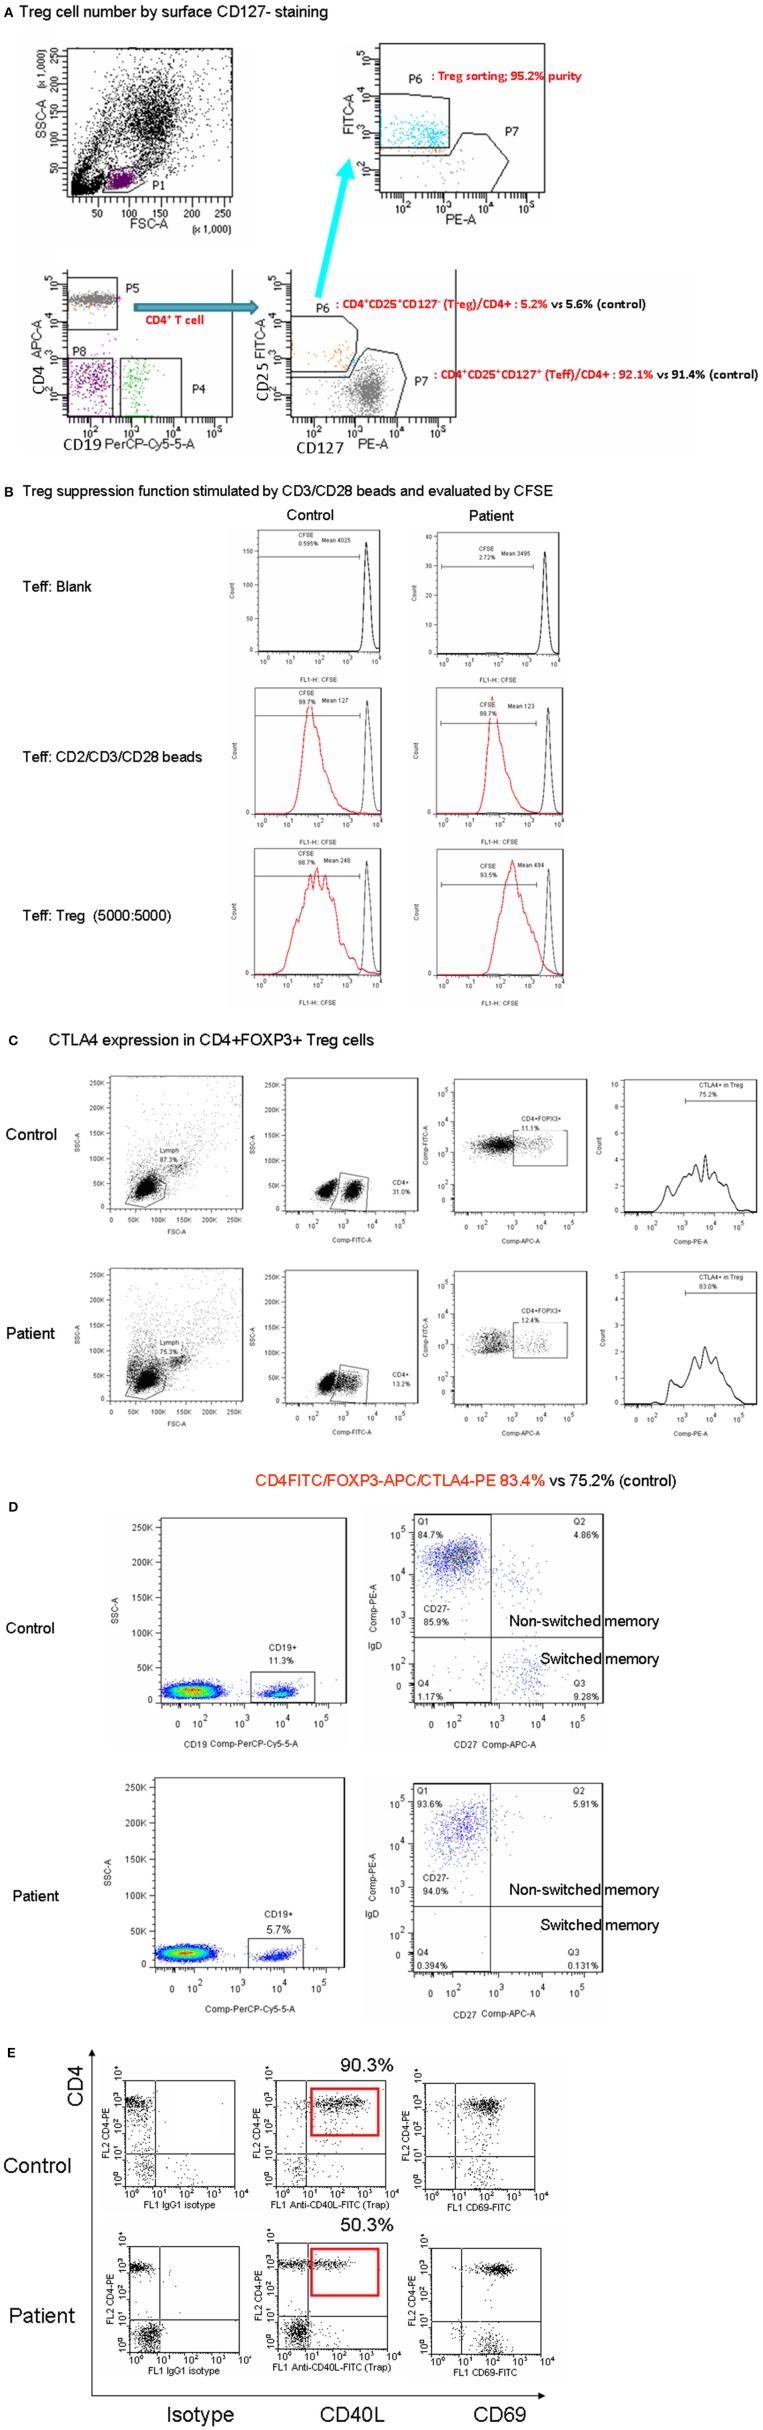
(A) The patient with CD3γDel
213A deficiency had a normal number of Treg cells in intracellular FOXP3 (Table 1) and similar CD4+CD25+CD127-staining compared with the control in CD4+ cells. (B) When co-cultured with T effector and Treg cells using 5000:5000 and stimulation by CD2/CD3/CD28 beads to assess Treg suppression, the percentage of CFSE shifted to the left (99.7 to 93.5% vs. 99.7 to 98.7% in the control) and the mean fluorescence intensity (494 to 123% vs. 248 to 127% in the control) showed a similar pattern. (C) Furthermore, the critical CTLA4 expression of Treg cells for suppression was within the normal range (83.4 vs. 75.4% in the control). (D) In the patient with CD3γDel
213A deficiency, memory B cells (CD19+CD27+) decreased (6.8 vs. 13.2–48.7% in the control), especially class-switched memory cells (CD19+CD27+IgD– 0.1 vs. 9.2–39.2% in the control). (E) The CD40L expression of activated CD4+ in the patient was around half that of the healthy control, while CD69 expression was used as an activation marker after stimulation with 10 ng/mL PMA and 1 ug/mL ionomycin for 5 h. Two duplicates were performed.